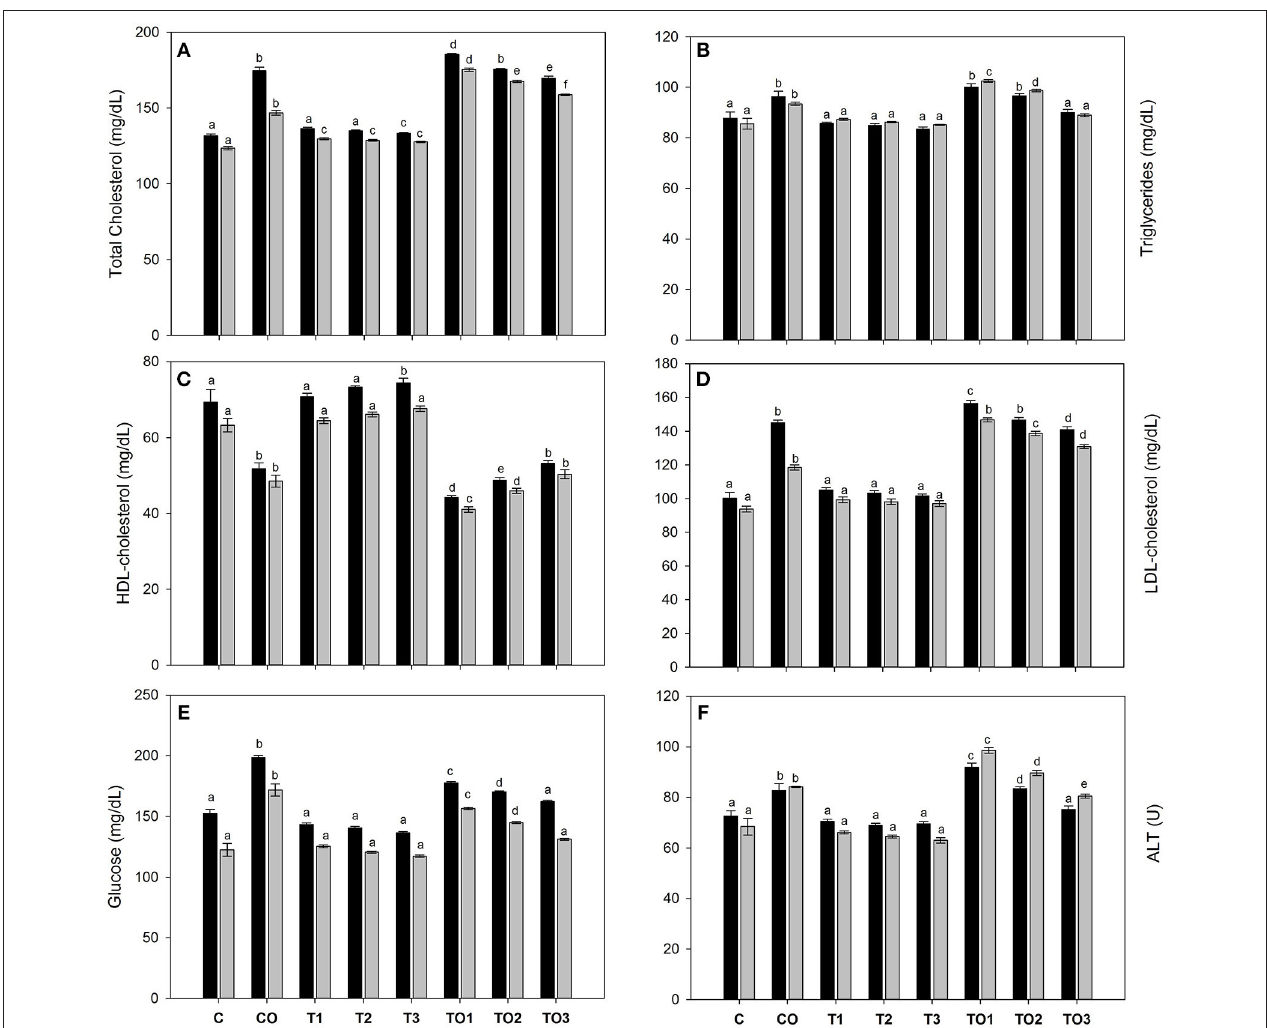
FIGURE 1 | Effects of α -tocopherol alone and in combination with thermally oxidized olive oils on the serum biochemical parameters of rats, (A) total cholesterol, (B) triacylglycerols, (C) HDL-c, (D) LDL-c, glucose (E) , and (F) ALT. Data are means ± SD of n = 3 per group. Different letters (a–f) on each male and female group represent significant at p < 0.001. Black bars are male groups, while gray bars are female